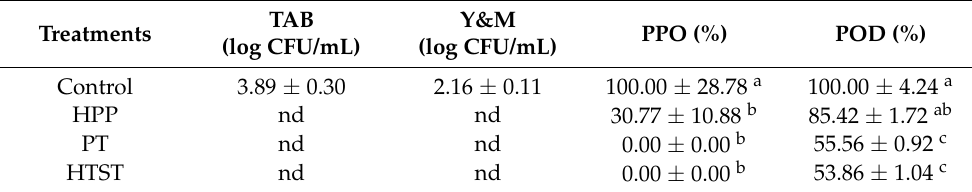
Values are mean ± SD ( n = 3). Means within columns with different letters (a–c) are significantly different ( p < 0.05). nd: not detectable (<1 log